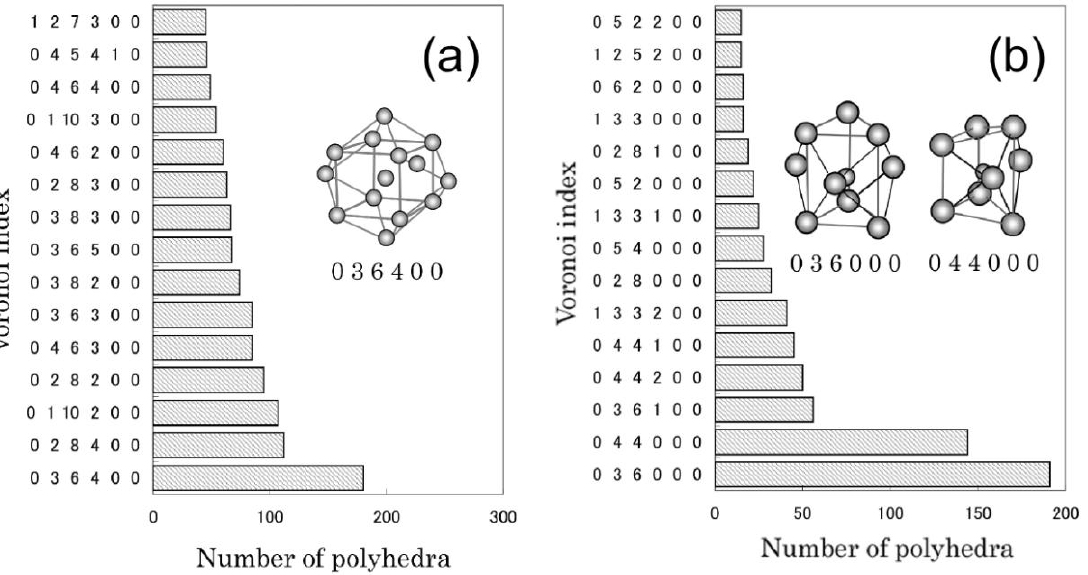
B . Voronoi 80 20